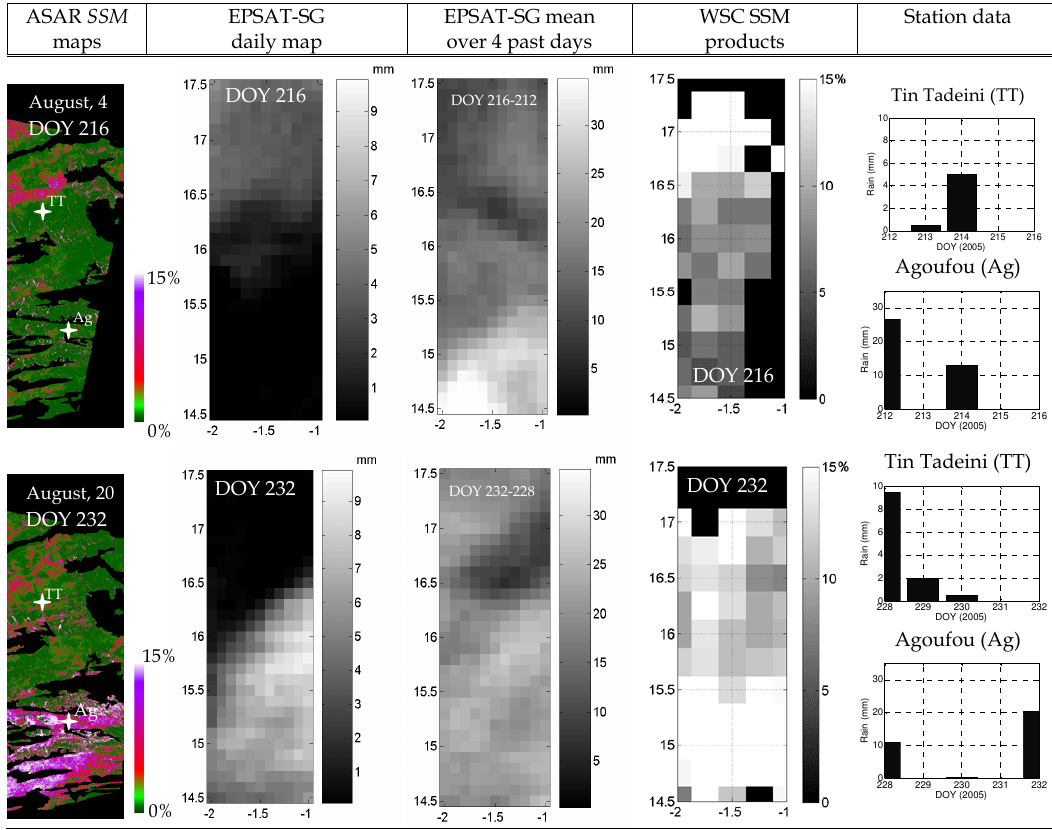
Fig. 9. Comparisons of August soil moisture (SSM) maps (4 th and 20 th ) derived from ENVISAT-ASAR and ERS WSC SSM products and EPSAT-SG rainfalls estimates on the same day and over the four previous days and with rainfall recorded at Agoufou and Tin Tadeini during the five same